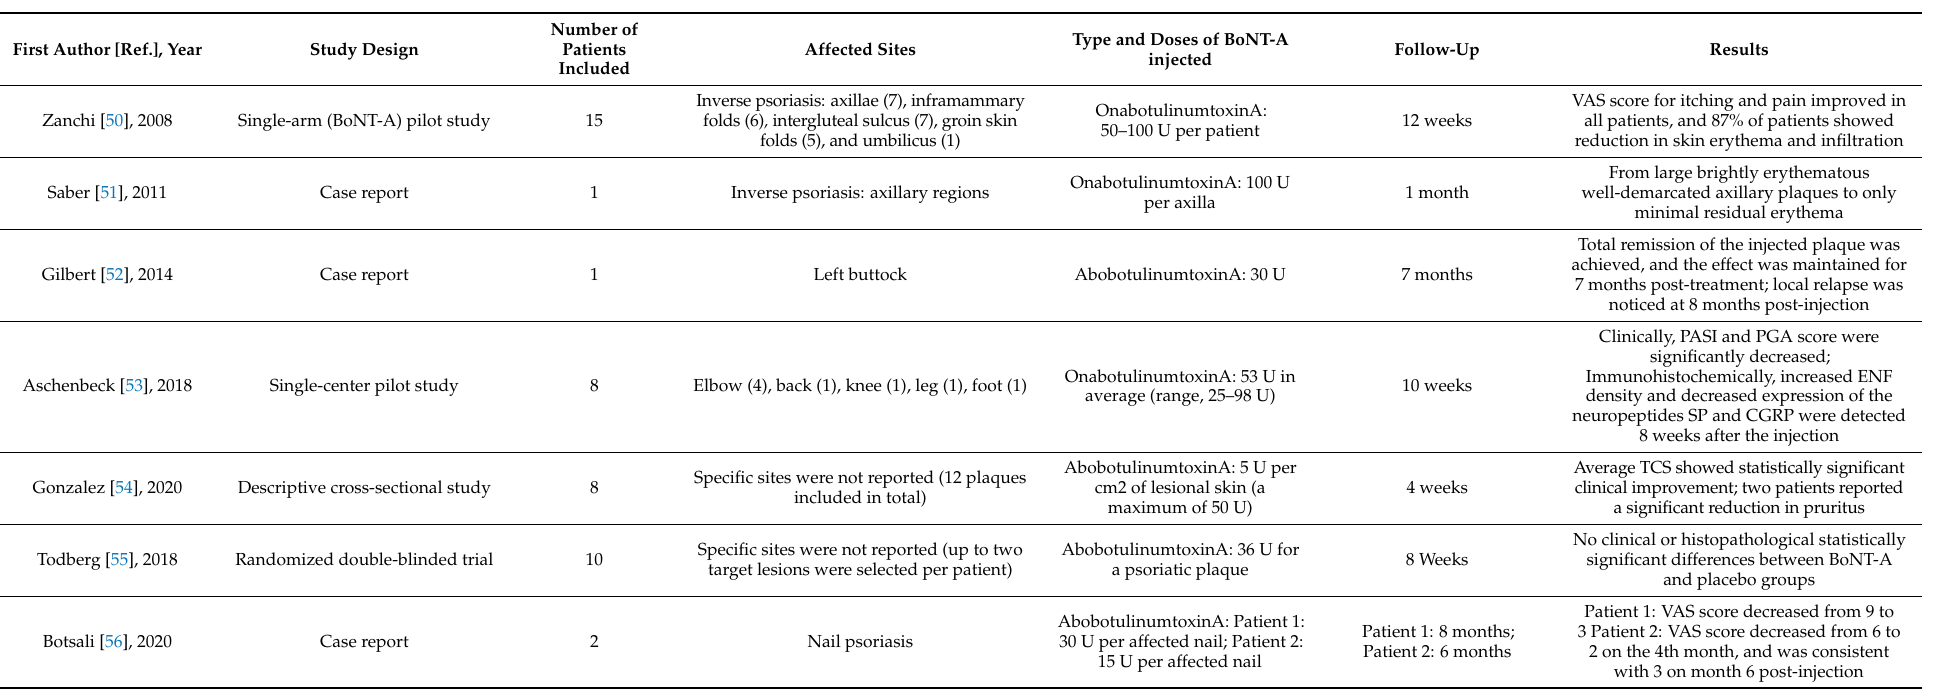
Table 1. Representative clinical trials and case reports on the utility of botulinum toxin type A (BoNT-A) in localized psoriasis